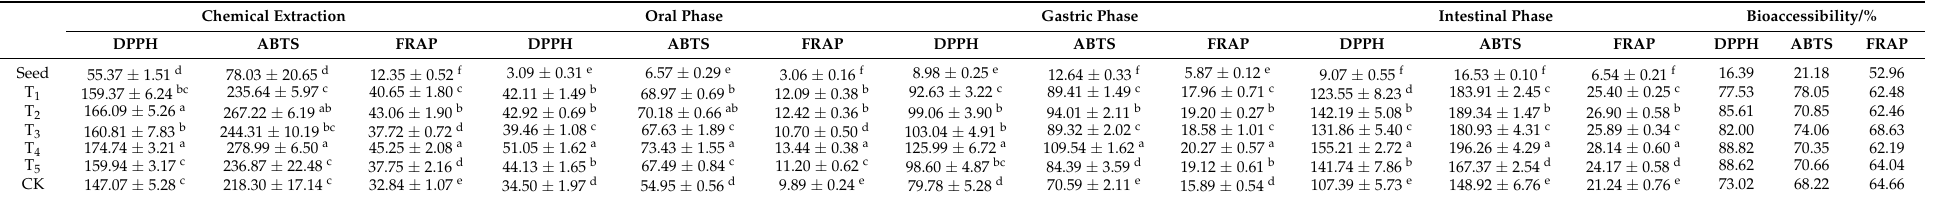
Means ± SD. Different lowercase letters per column indicate significant statistical difference ( p <